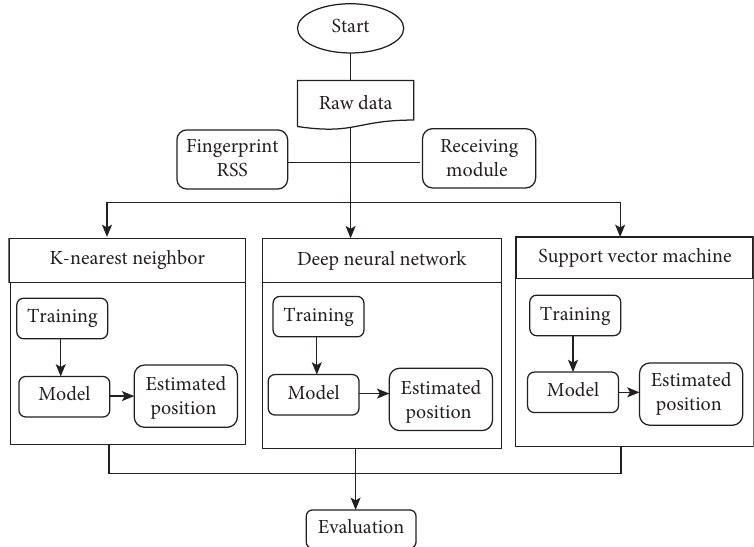
Figure 3: The architecture of indoor positioning system